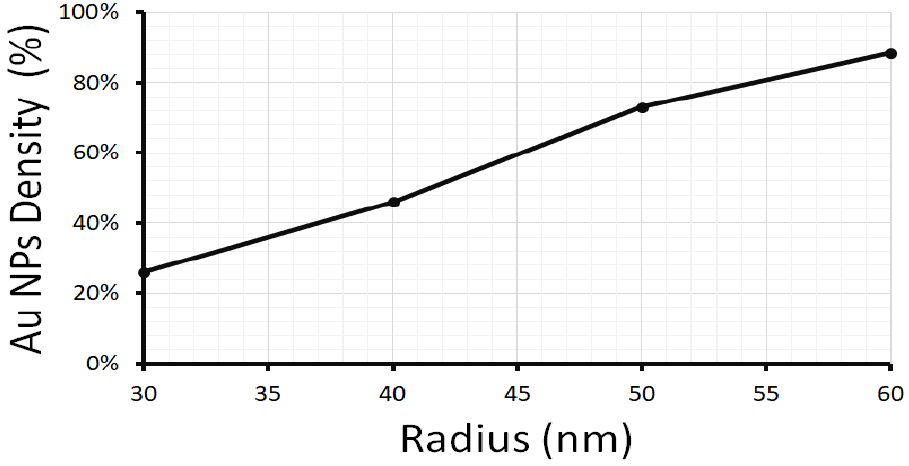
Figure 9. Au NP density for different radii: 30, 40, 50, and 60 nm.